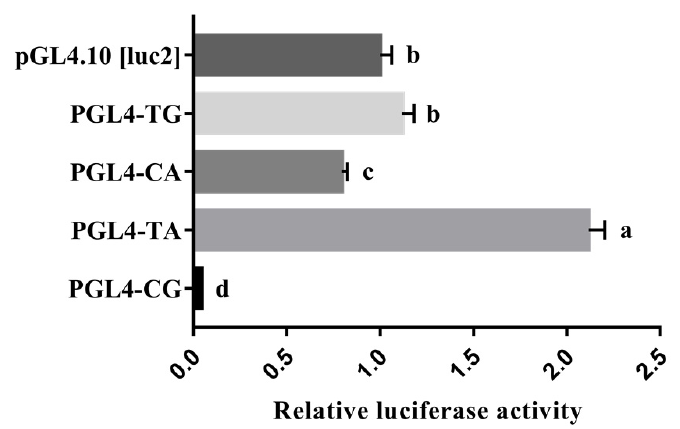
Figure 5. Luciferase reporter gene assays of the haplotypes containing the HHEX gene promoter SNPs rs80901185 and rs80934526. pGL4-TG represents rs80901185T and rs80934526G, pGL4-CA represents rs80901185C and rs80934526A, pGL4-TA represents rs80901185T and rs80934526A, and pGL4-CG represents rs80901185C and rs80934526G. The relative luciferase activity values represent the mean ± SEM of three independent experiments. A one-way ANOVA test was used to assess differences in luciferase activity. Different letters (a, b, and c) indicate that the difference is significant ( p < 0.05).